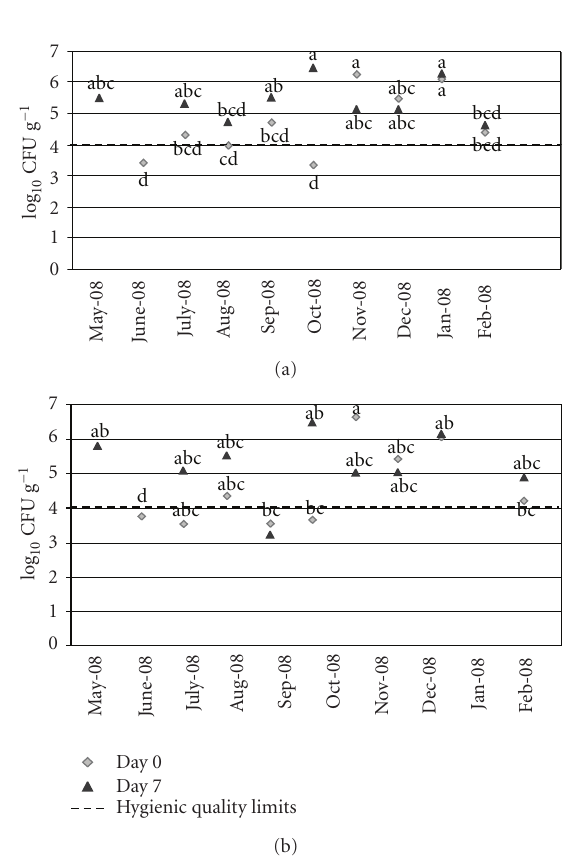
Figure 1: Fungal counts on DRBC (a) and DG18 (b) media during the sampling period May 2008–February 2009. Hygienic quality limits (1 . 0 × 10 4 CFUg − 1 ) were determined according to GMP [11]. Values with letters in common are not statistically di ff erent ( P < . 05). frequencies were at day 0 and day 7 of storage Clado-sporium spp. (31 and 26%), Alternaria spp. (15 and 17%), and Fusarium spp. (6 and